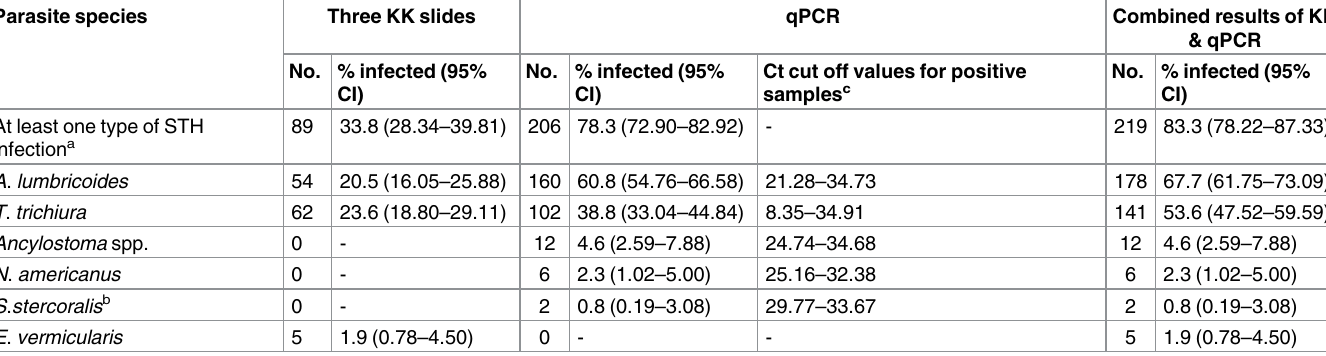
Table 2. Prevalence of helminth infections in 263 schoolchildren in Laguna province, Philippines, stratified by diagnostic approach. Parasite